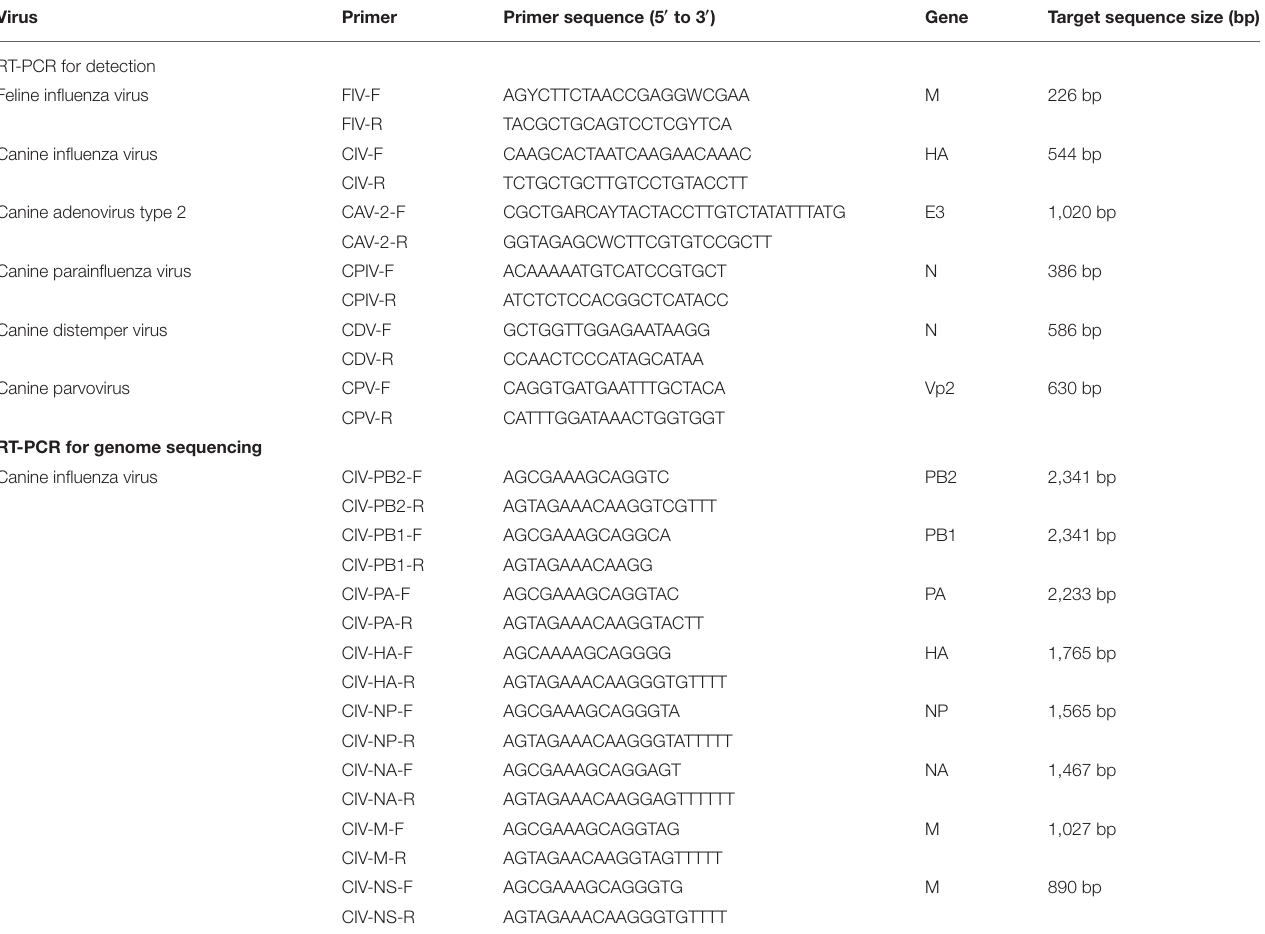
TABLE 1 | Primers used for virus detection and genome sequencing. Virus Primer Primer sequence (5 ′ to 3 ′ ) Gene Target sequence size